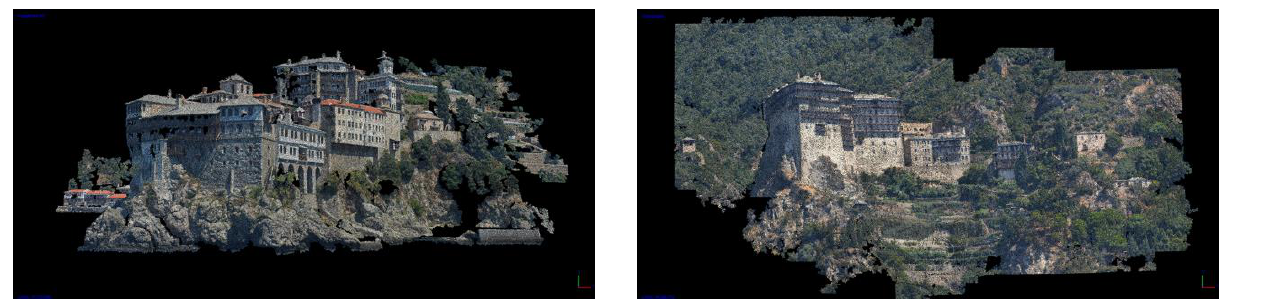
Figure 2 . The Monastery of St. Gregorio. Cloud of points.